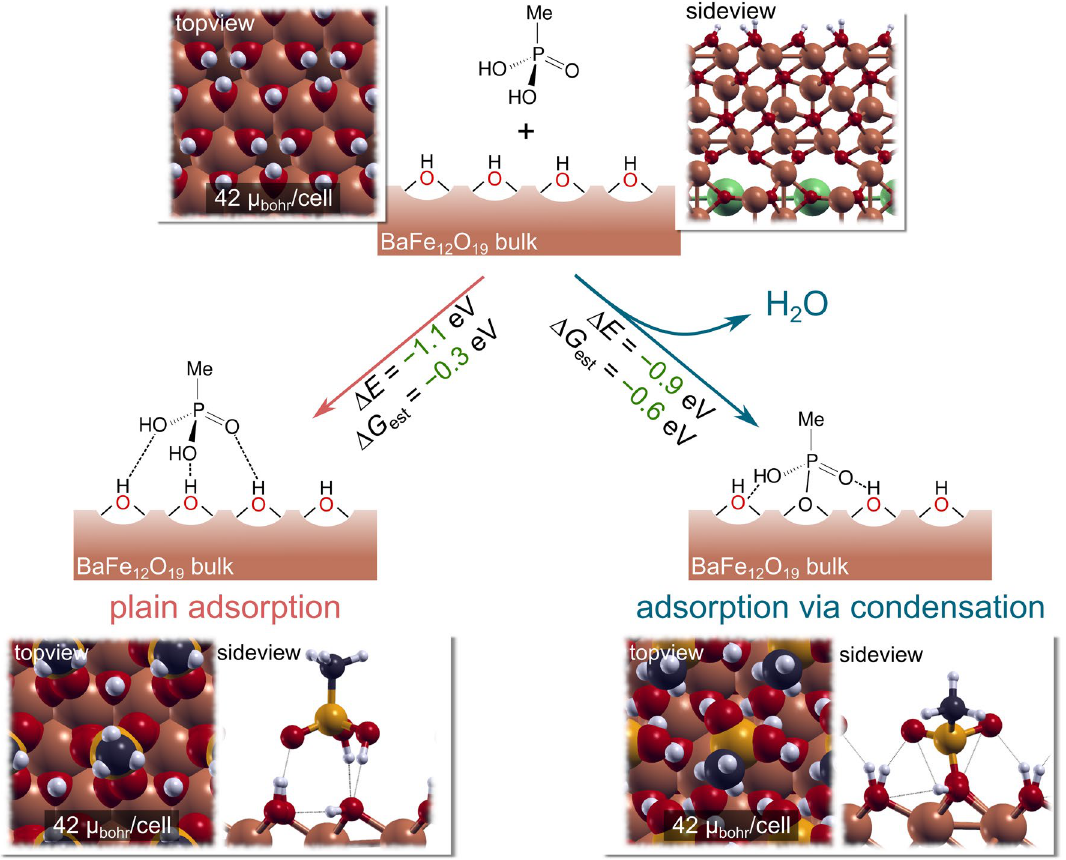
Figure 8. The reaction energy ( ∆E ), estimated Gibbs free energy ( ∆G est ) and computed total magnetization for the phosphonate adsorption in the plain mode (left) or via condensation (right). Both reaction energies are exothermic, indicating that phosphonates adsorb on the surface of BHF. The computed magnetization remains unchanged, irrespective of the mode considered. The figure was generated by using inkscape 1.2.1 (https:// inksc ape. org/), gimp 2.10 (https:// www. gimp. org/), and xcrysden 1.6.2 41